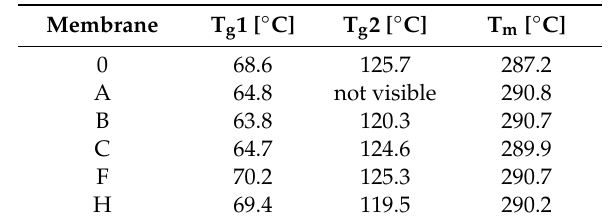
Figure 12. DSC curves for investigated membranes obtained from: unmodified PAN (green), and PAN modified with rGO (other colors). Curves registered in the heating rate of 60 ◦ C / min in temperature ranges of: Glass transitions (of amorphous and mesomorphic phases), melting, and beginning of thermal decomposition, respectively. Table 3. Values of characteristic temperatures of glass transition (appointed using half-height procedure) of amorphous T g 1 and mesomorphic T g 2 phases and melting T m , evaluated on the basis of DSC curves (Figure 2) for selected investigated PAN-rGO